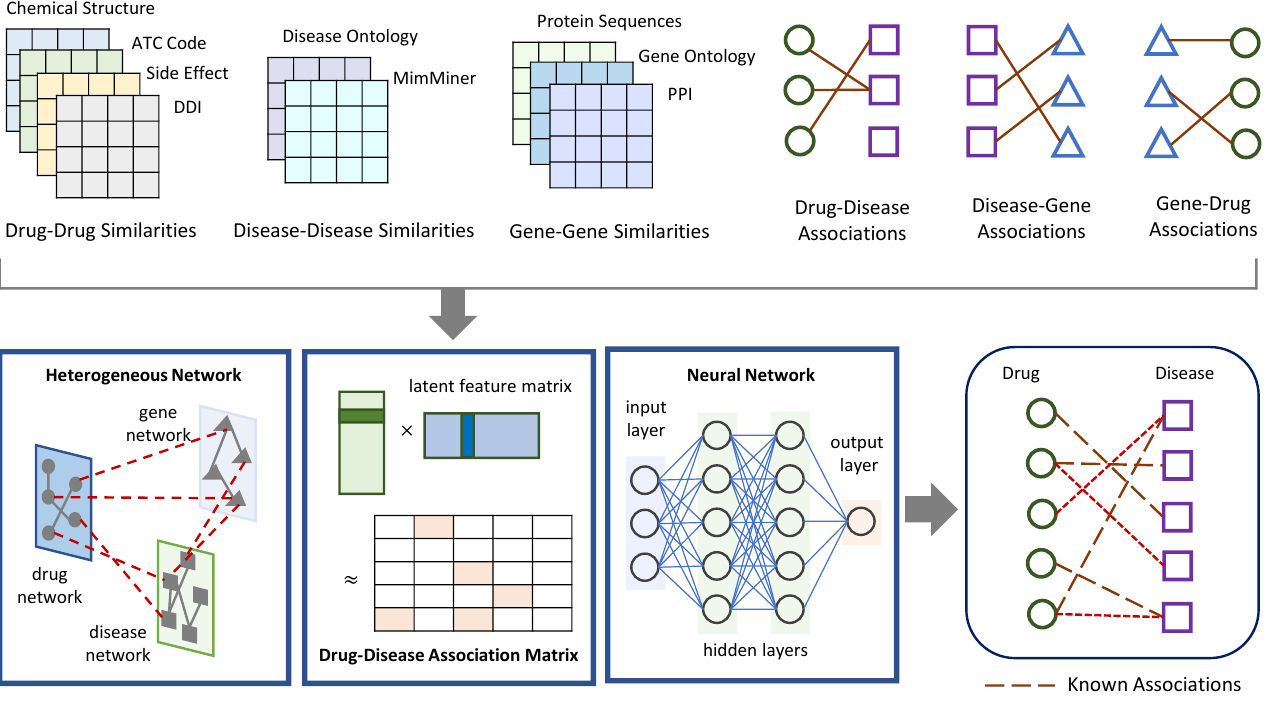
Figure 1. Schematic view of the general process of network-based approaches to predict drug–disease associations. They take a heterogeneous network including drug–drug, disease–disease, and gene– gene similarities as well as known drug–disease, drug–gene, and disease–gene associations as input. They apply graph mining algorithms, or matrix factorization and completion techniques, or deep learning algorithms to return predicted drug–disease associations as